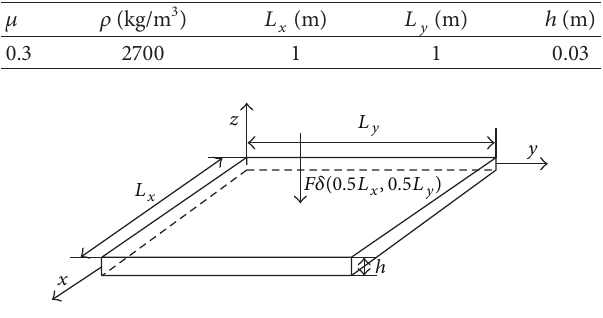
Figure 3: Simply supported, point excited plate. Table 2: Temperature dependent elastic modulus and thermal expansion coefficient